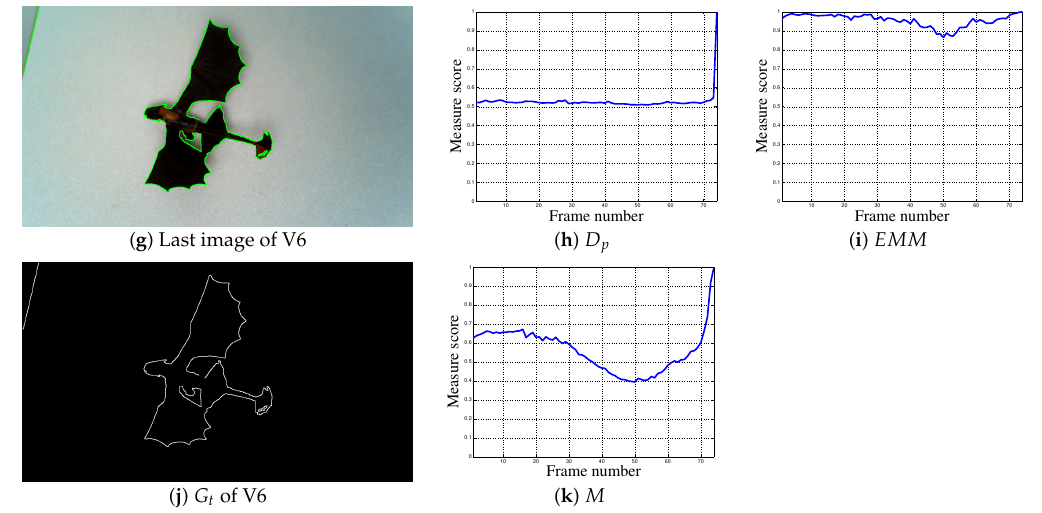
Figure 8. Localization metrics behaviors for a real experiment concerning video V6, 74 frames, with images of size 720 ×